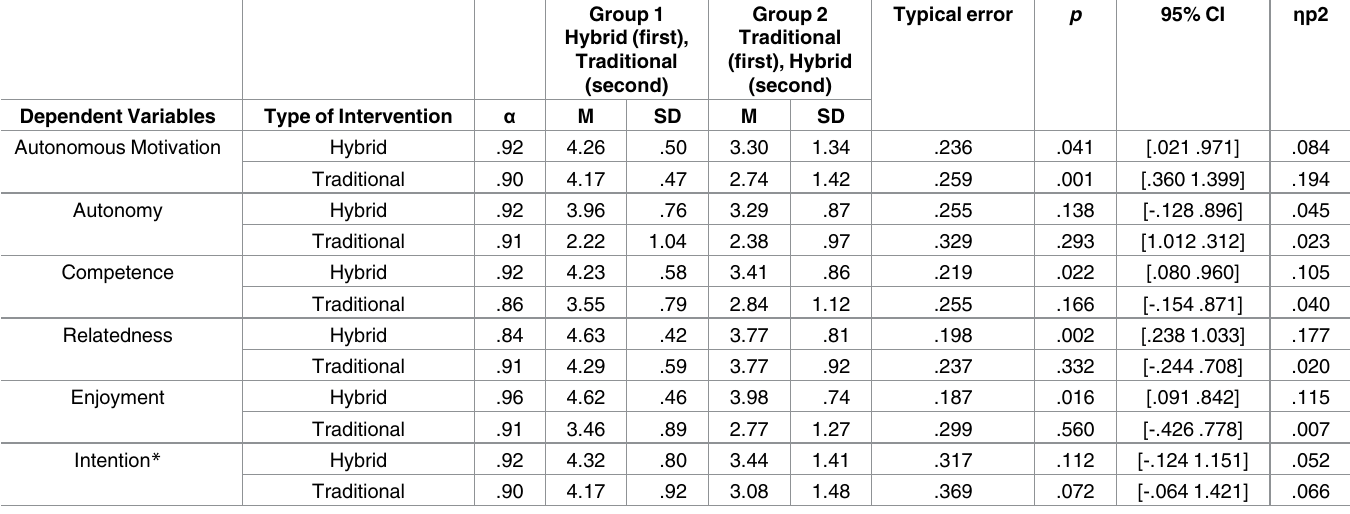
Table 5. Descriptivestatistics and inter-group analysis for both conditions of each dependent variable.